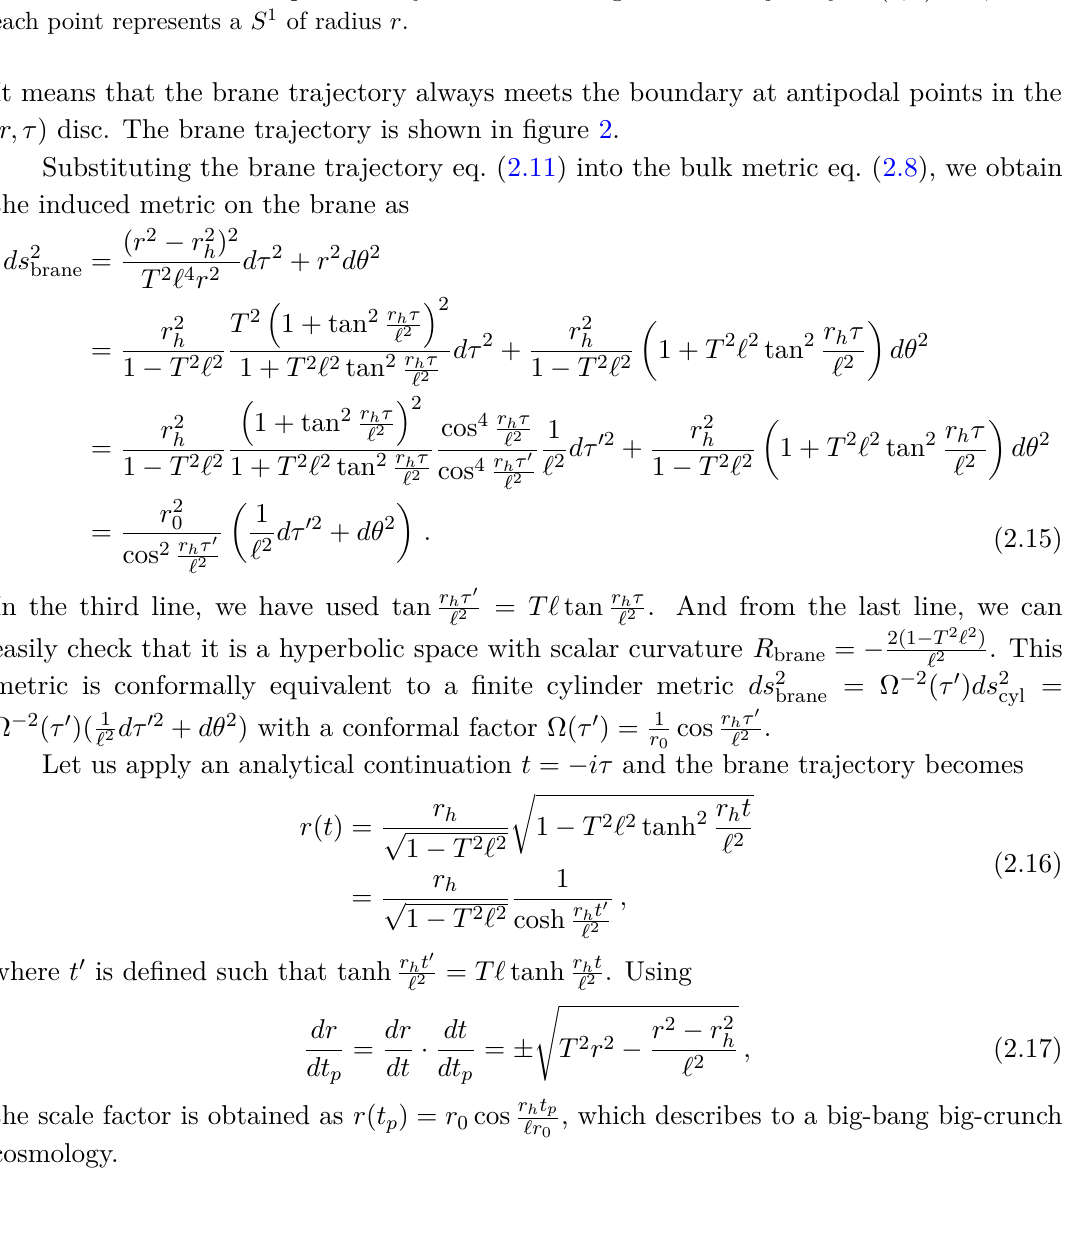
Figure 2 . Left: Euclidean geometry for the brane trajectory. The red dotted line is the zero tension brane. The red solid line represents any T > 0 brane. Right: brane trajectory in ( τ, r ) disc, where each point represents a S 1 of radius r